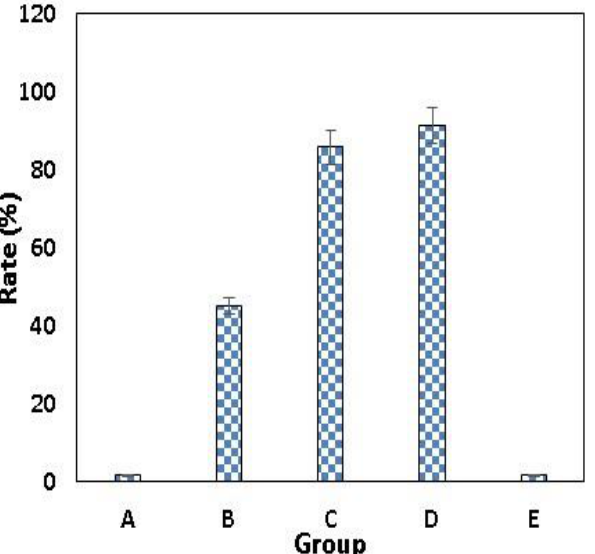
Figure 5. Antibacterial rate (R) of specimens against S. mutans. R (%), antibacterial rate. (A) Group A BIOD; (B) Group B—0.5% ROE-AgNPs with 99.5% BIOD; Group (C) C—99% BIOD with 1% Cefuroxime-ROE-AgNPs nanontibiotic (1:1); Group (D) D—98% BIOD with 2% Cefuroxime-ROE-AgNPs nanontibiotic (1:3); Group (E) E—98.5% BIOD with 1.5% cefuroxime. Table 5. Antibacterial rate ( AR ) of specimens against S. mutans.